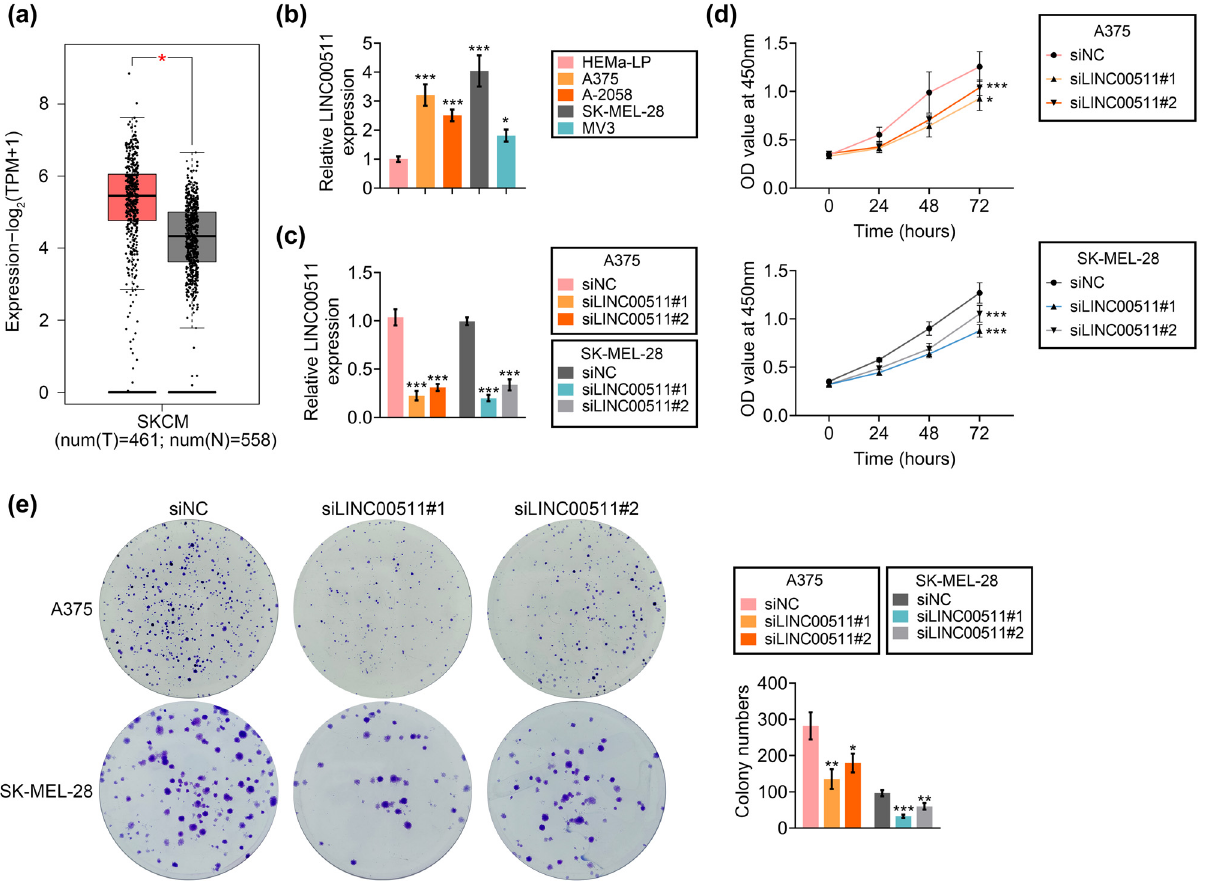
Figure 1: LINC00511 - promoted Q3 cell proliferation of melanoma. ( a ) LINC00511 was increased in skin cutaneous melanoma ( SKCM ) tissues compared to normal tissues. ( b ) LINC00511 was also elevated in melanoma cells ( A375, A - 2058, SK - MEL - 28, MV3 ) compared to HEMa - LP. ( c ) Transfection with si LINC00511#1 or si LINC00511#2 reduced expression of LINC00511 in A375 and SK - MEL - 28. ( d ) Transfection with si LINC00511#1 or si LINC00511#2 decreased the cell viability of A375 and SK - MEL - 28. ( e ) Transfection with siLINC00511#1 or si LINC00511#2 decreased cell proliferation of A375 and SK - MEL - 28. *, **, *** vs normal tissues, HEMa - LP, or siNC, p < 0.05, p < 0.01, p <